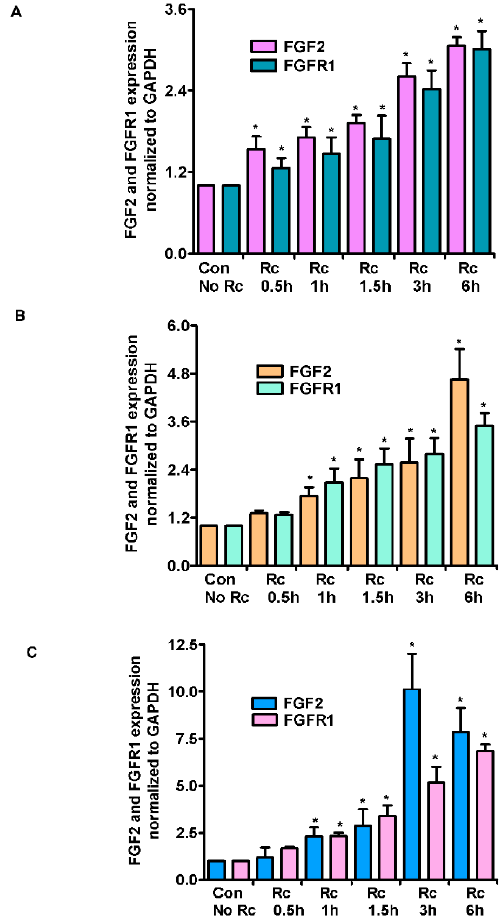
Figure 2. Expression levels of FGF2 and FGFR1 mRNA in R. conorii -infected host endothelial cells. HMECs ( A ), HLMECs ( B ), and HCECs ( C ) were infected with R. conorii for various time periods up